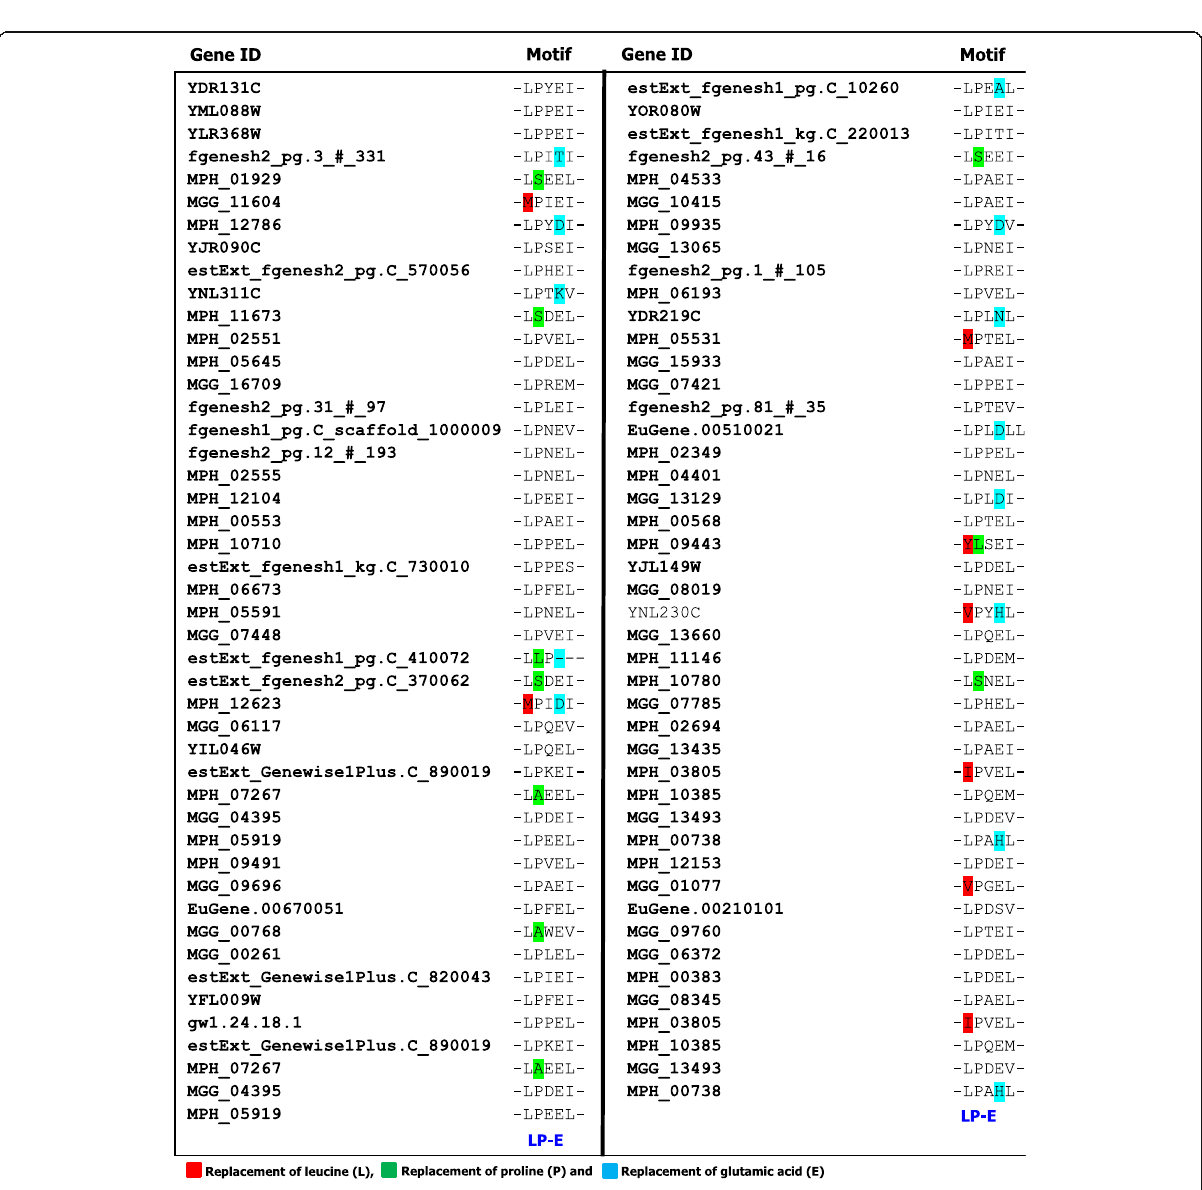
Fig. 7 Sequence alignment of F-box protein in four different fungi (M. phaseolina , M. oryzae , B. graminis , and S.